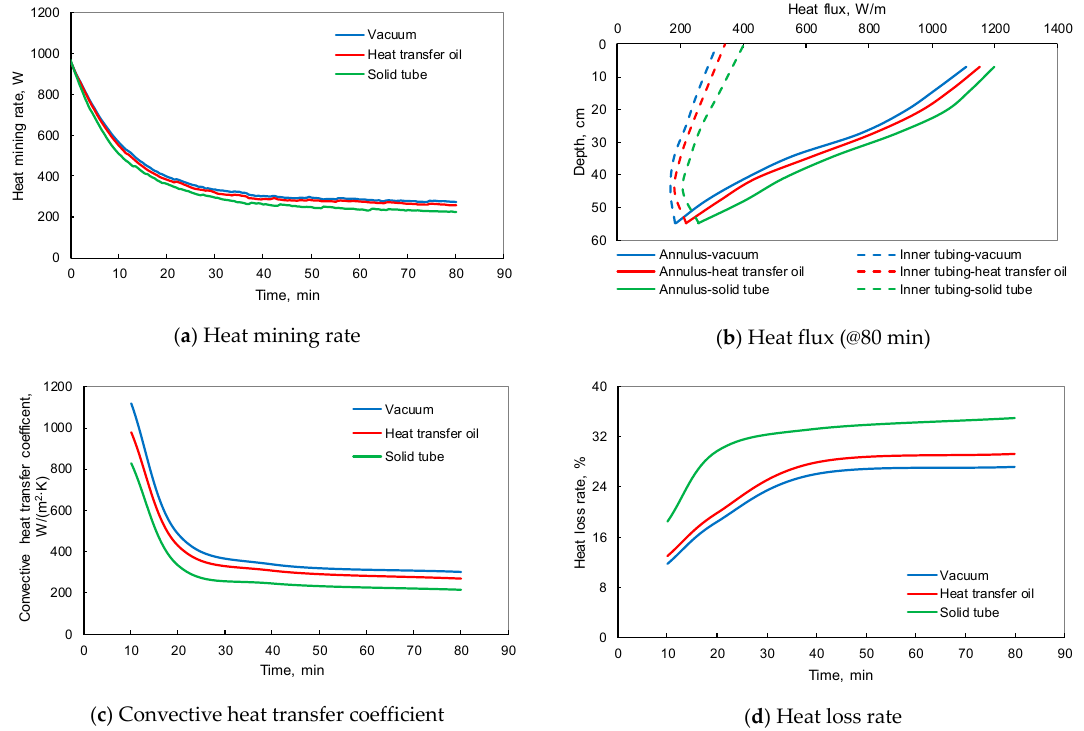
Figure 18. The main heat exchange parameters at different thermal conductivities of inner tubing.